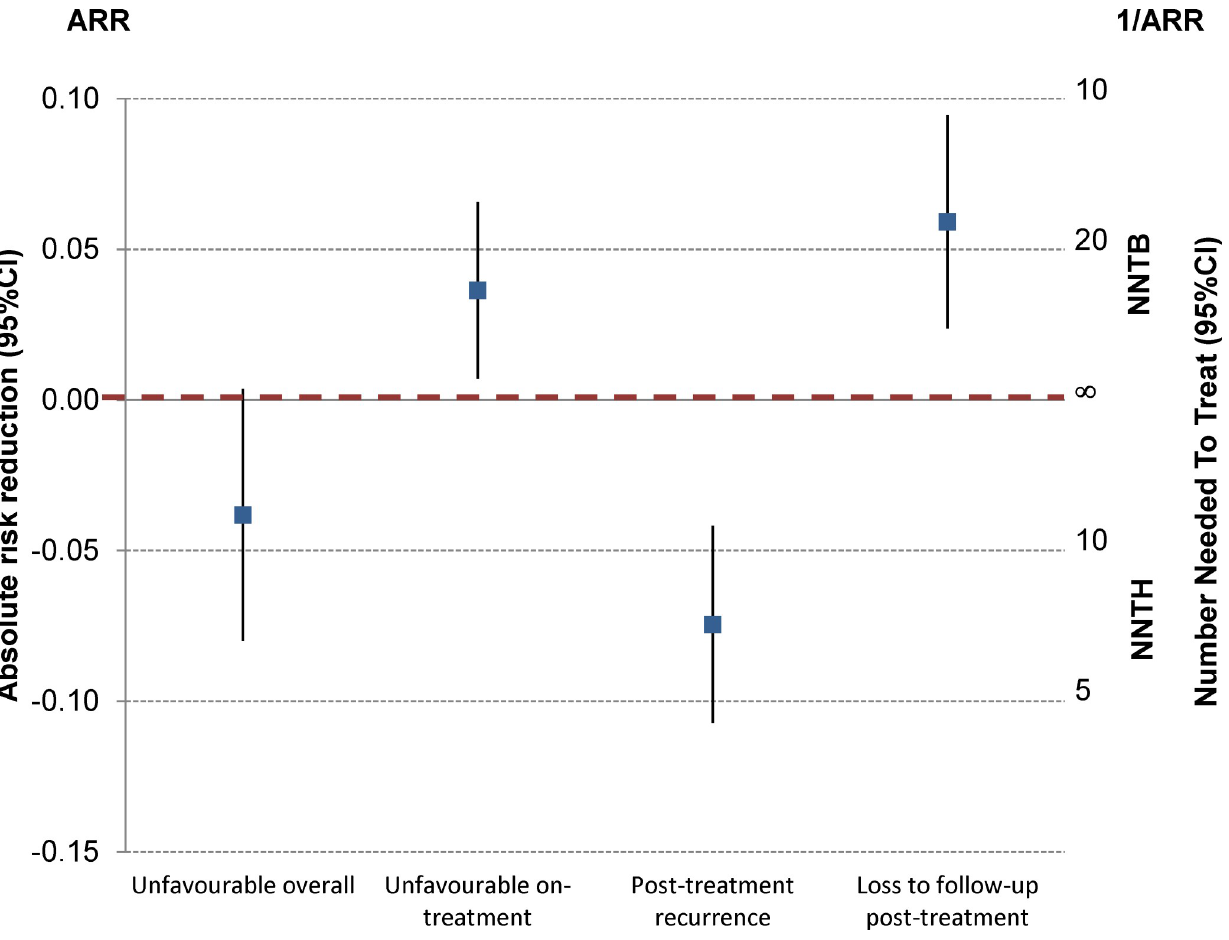
Fig 5. Composite outcome versus on- and posttreatment outcomes—OFLOTUB trial [21]. ARR, absolute risk reduction; CI, confidence interval; NNTB, number needed to treat for one patient to benefit; NNTH, number needed to treat for one patient to be harmed.